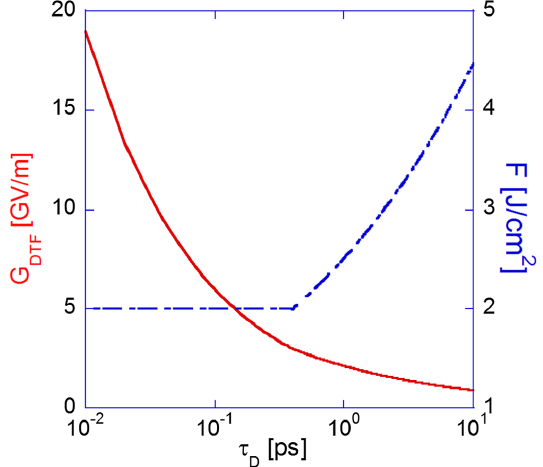
FIG. 3. Damage threshold fluence gradient (red) and the FIG. 4. Single bunch efficiency vs loaded gradient for two corresponding fluence values (dashed blue) in Eq. (5) as a different radii in each case: reduced (solid curves) and unreduced function of delay time. Since G (dashed curves). Although maximum efficiency is the same in set an upper limit on the DTF both cases, it occurs for higher loaded gradients in the reduced unloaded gradient values, it is advantageous to reduce the case. Also, wider vacuum channel presents higher delay time.